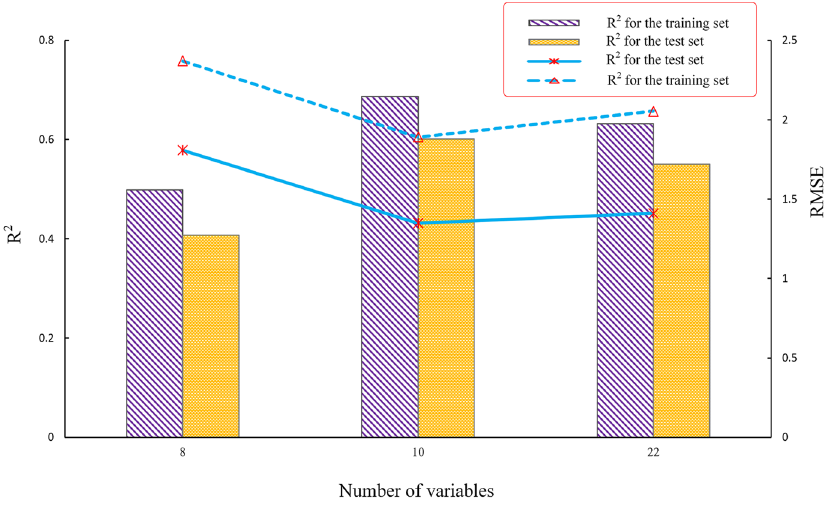
Figure 5. Estimation results of TP based on RF models with different wavelength variables.